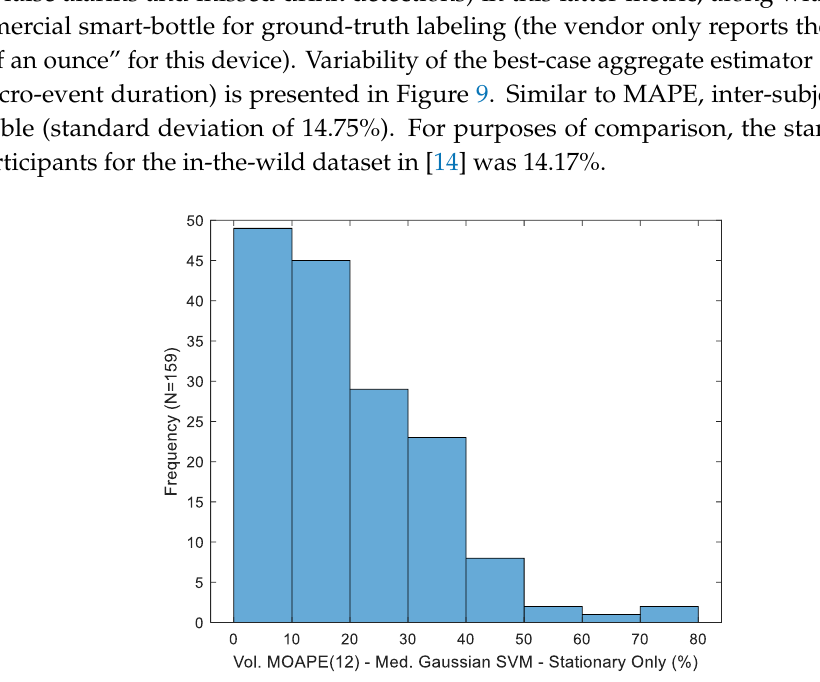
Table 4. Variation in volume mean overall absolute percentage error for multiple prompt periods (bold values emphasize the best performing model for each period).